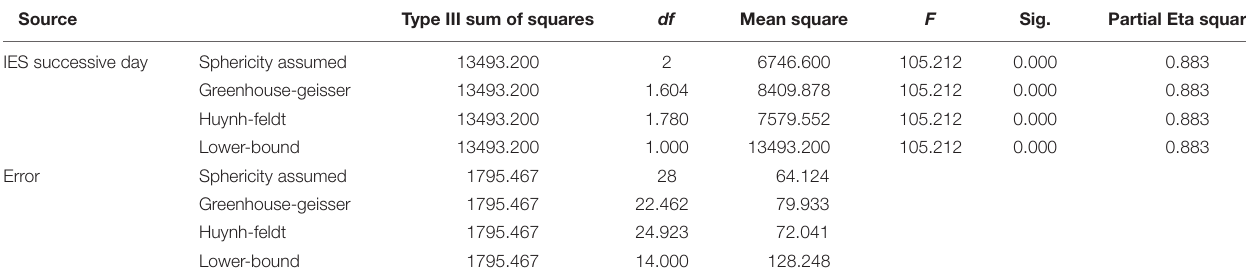
TABLE 3 | Tests of within-subjects effects for the successive day treatment